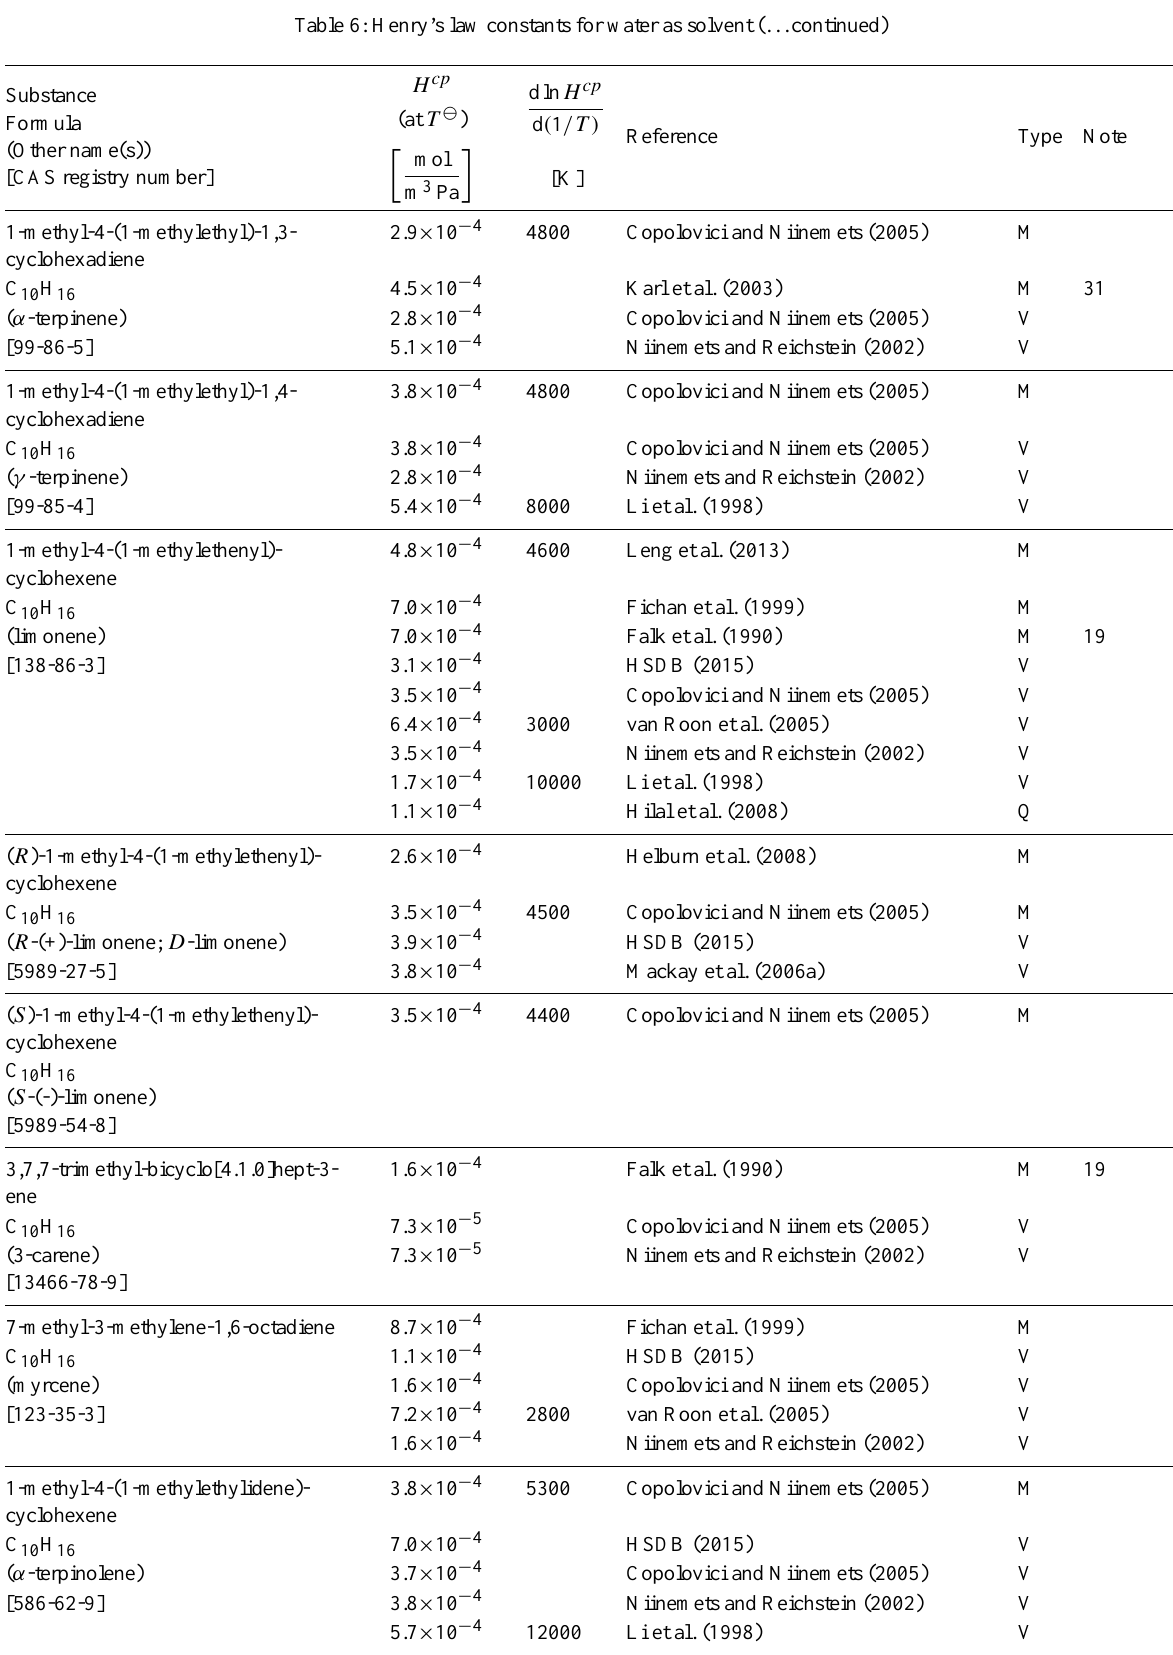
Table 6: Henry’s law constants for water as solvent